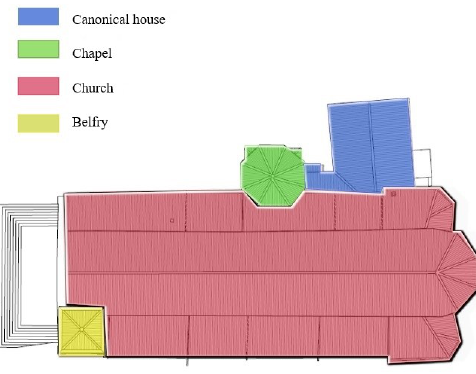
Figure 3. Plan of the building: the colors highlight the position of the structural